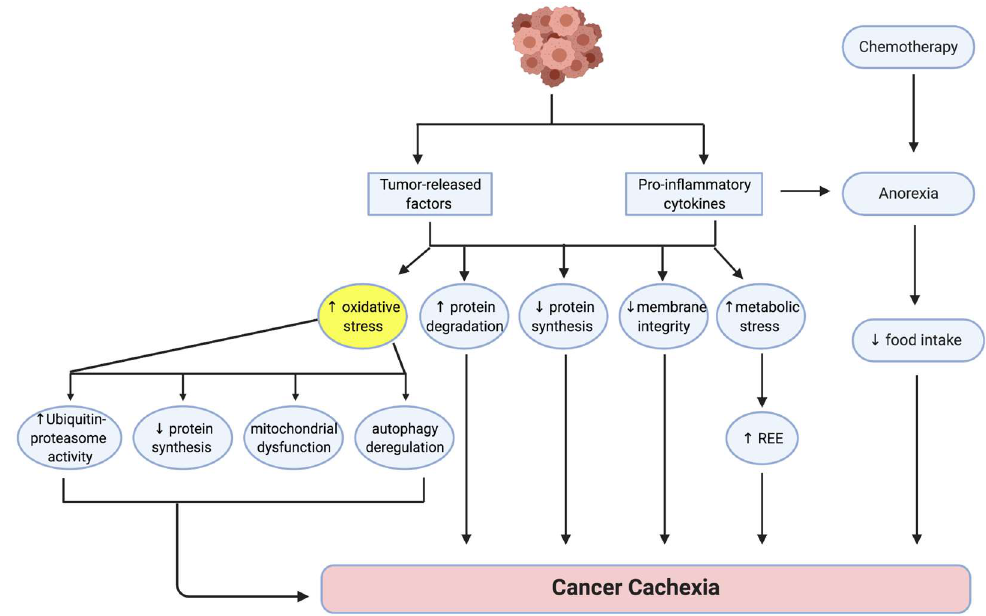
Figure 1. Pathogenesis of cancer cachexia. Numerous factors influenced by host cytokines and tumor-released factors result in an imbalance between protein degradation and protein synthesis that ultimately leads to muscle wasting and weakness [11,12]. Membrane integrity is compromised be- cause of potential dysfunction of the dystrophin-glycoprotein complex [13]. Metabolic dysregulation leads to an increased resting energy expenditure (REE) and this contributes to tumor progression and nutritional deficiencies [9]. Increased oxidative stress is a key contributor to cancer cachexia, contributing to mechanisms that favor protein breakdown over protein synthesis through increased ubiquitin proteasome activity, mitochondrial dysfunction and dysregulation of autophagy. Chemotherapy can contribute to the pathology of cancer cachexia by inducing anorexia [14]. Adapted from [10]. Figure created using Biorender.com, accessed on 7 November 2021.